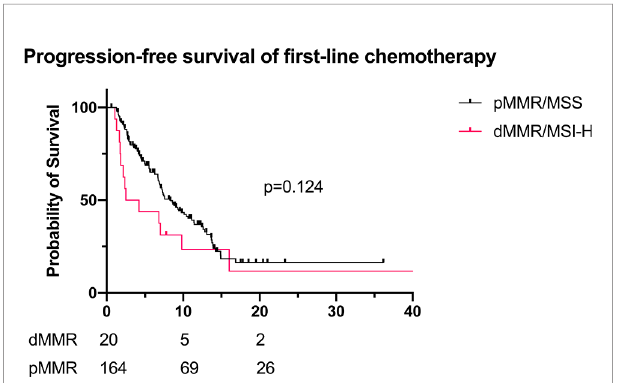
FIGURE 4 | PFS of fi rst-line chemotherapy for recurrent/advanced GC patients (dMMR/MSI-H: n = 20; pMMR: n = 164; mPFS 3.4 vs . 8.3 months, p = 0.124). PFS, progression-free survival; GC, gastric cancer; dMMR, de fi cient DNA mismatch repair; MSI-H, microsatellite instability-high; pMMR, pro fi cient mismatch repair; mPFS, median PFS.